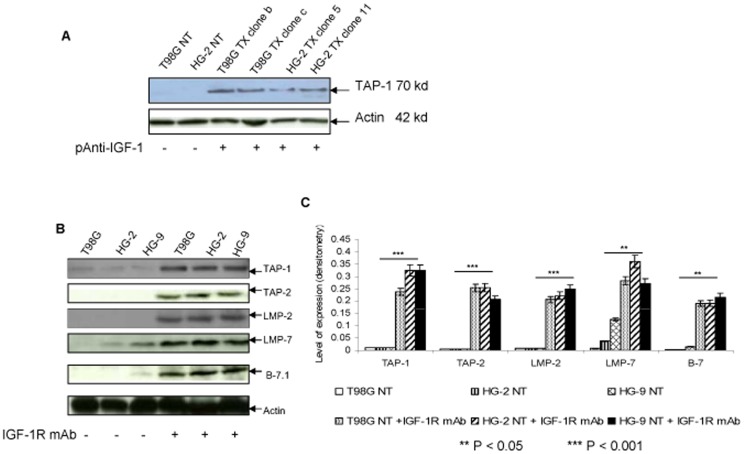
Comparison in expression of TAP, LMP and B-7.1 peptides in parental and pAnti IGF-1 transfected and/or IGF-1R monoclonal antibody (mAb) treated HGB cell lines.A, Regulation of TAP-1 peptide in T98G and HG-2 TX cells was determined by Western Blot. Cell lysate was prepared from cells of TX and corresponding NT cell lines pretreated as described in Fig 4 and then subjected to SDS-PAGE and electronically blotted to nitrocellulose membrane. TAP-1 peptide on the membrane was probed by anti-human TAP-1 monoclonal Ab+anti-mouse IgG HRP-linked Ab; and, signal was detected by LumiGLO reagent. Lanes 1, 2 are NT cells from the T98G and HG-2 cell lines respectively. Lane 3, 4 are TX cells from clone b and c of the T98G cell line; Lane 5, 6 are TX cells from clone 5 and 11 of the HG-2 cell line. Re-probed membrane with anti-actin Ab demonstrates presence of the 42 kd actin. Up-regulation in expression of the 70 kd TAP-1 in the two pAnti IGF-1 transfected cell clones were demonstrated in this experiment. B, Up-regulation in TAP-1 and LMP-7 peptides, and, rescue in expression of TAP-2 and LMP-2 peptides following the exogenous addition of 10ug/ml IGF-1R mAb into cell culture medium for 48 hours were demonstrated by Western Blot. The lysates of wild type and IGF-1R antibody treated cells were prepared as described in A. Lanes 1, 2 and 3 represent T98G, HG-2 and HG-9 cell lines cultured in medium with no IGF-1R mAb added, while lanes 4, 5 and 6 are the corresponding respective cell lines cultured in medium with addition of exogenous IGF-1R mAb (10ug/ml), respectively. Rows 1, 2, 3 and 4 represent TAP-1, TAP-2, LMP-2 and LMP-7, respectively. Row 5 demonstrates the rescue in expression of the B-7.1 peptide in IGF-1R mAb treated T98G, HG-2 and HG-9 cell lines when compared to the wild types of the corresponding non-treated cells. The 42 kd band of actin is also shown as an internal control for the quantity of samples loaded. B represents the results from one set of the experiments, that were repeated×2; C, The densitometry analysis for the two sets of similar experiments was obtained by the NIH image J program. The differences in results between the groups with and without IGF-1R mAb in culture media were significant at p<0.05 or p<0.001.